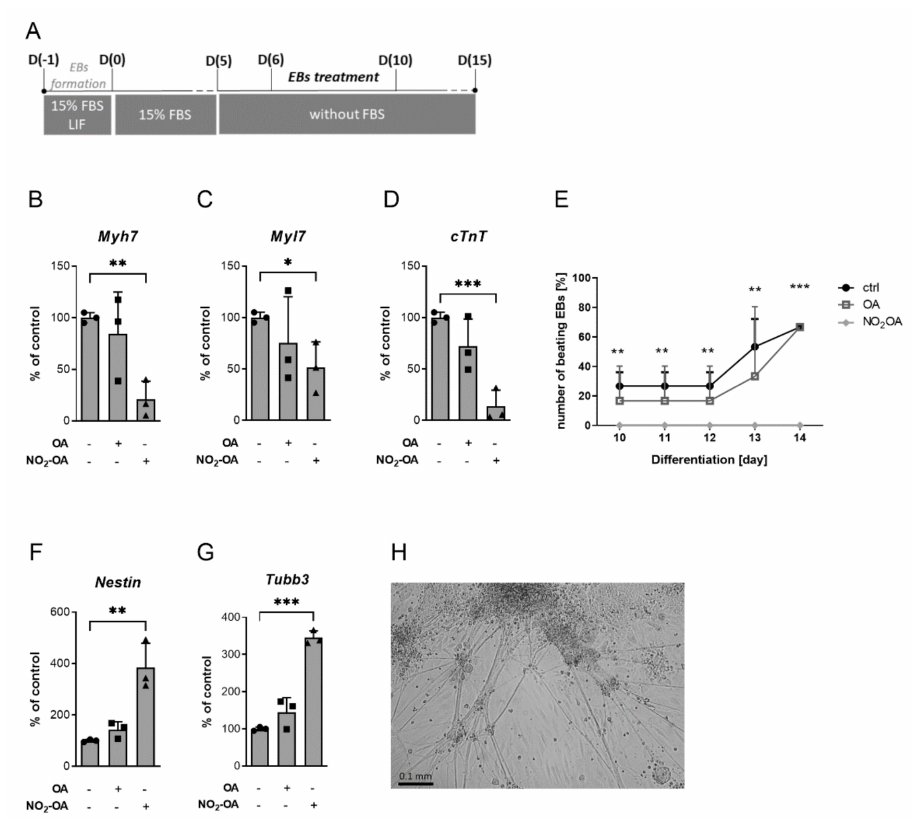
Figure 4. NO 2 -OA inhibits cardiomyogenesis and enhances neural differentiation in mESC-derived EBs. ( A ) Time-scheme of mESC differentiation protocol and treatment of embryoid bodies (EBs) used in this experiment. ( B – D , F ) The mRNA levels of cardiac markers ( B ) myosin heavy chain 7 ( Myh7 ), ( C ) myosin light chain 7 ( Myl7 ), ( D ) cardiac troponin T ( cTnT ); and ( F ) neural progenitor marker Nestin and ( G ) neural-specific marker β -Tubulin class III ( Tubb3 ) were evaluated by real-time quantitative PCR analysis in 15 days mESC-derived EBs. mESC were differentiated using EBs-formation protocol and treated from day 6 to day 10 by NO 2 -OA or OA (10 µ M). Data are expressed as means and standard deviation from three independent experiments. Statistical significance was determined by unpaired student’s t -test; statistical differences compared to non-treated control were analyzed, * p < 0.05, ** p < 0.01, *** p < 0.001. ( E ) The number of beating EBs was evaluated using a light microscope from three independent experiments. Data are expressed as means and standard deviation. Statistical significance was determined by unpaired student’s t -test; statistical differences compared to non-treated control were analyzed, ** p < 0.01, *** p < 0.001. ( H ) The microscope visualization of expanded EBs with neurites at day